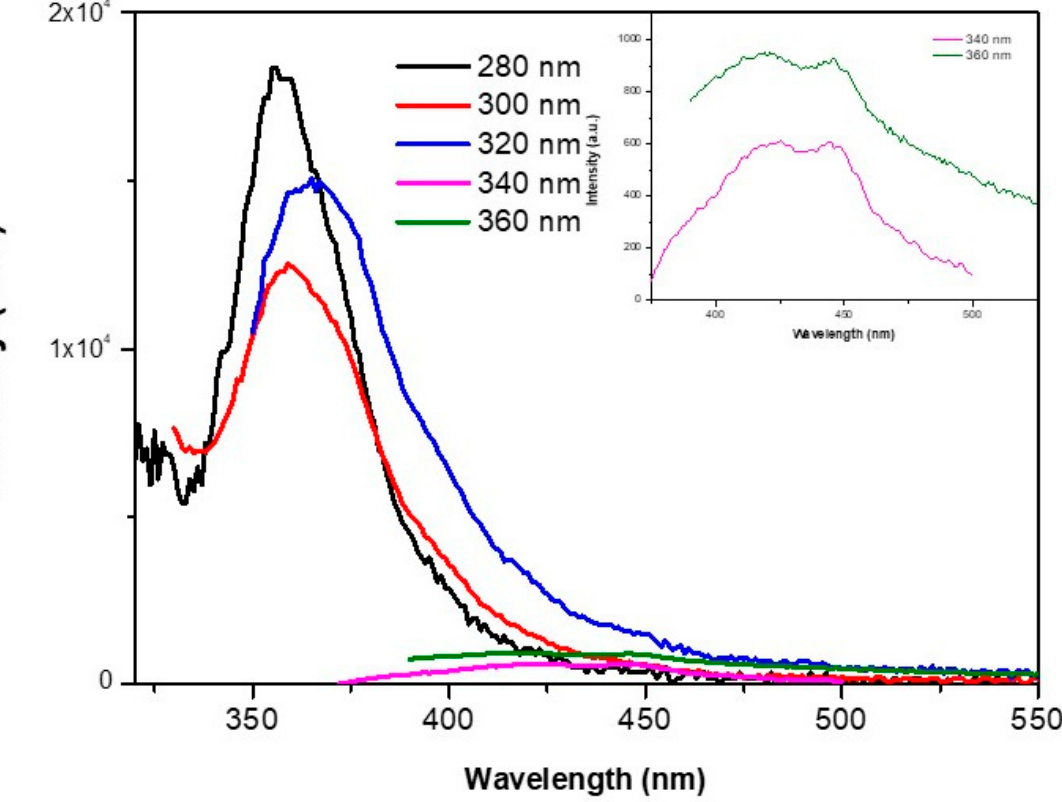
Figure 3. Fluorescence emission spectra of ZnS nanoparticles with different excitation wavelengths. Inset, a zoom of the fluorescence spectra with 340 nm and 360 nm excitation wavelengths.